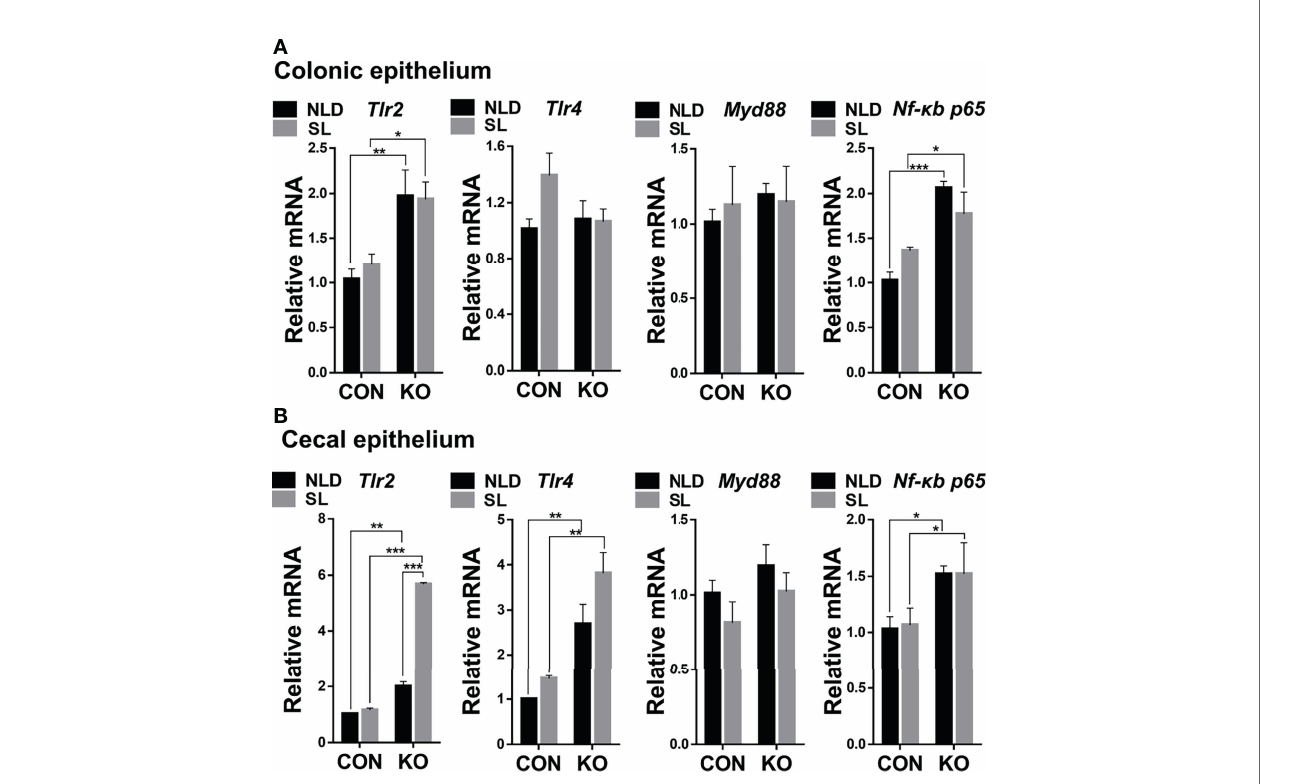
FIGURE 5 | Relative expression of colonic and cecal epithelial in fl ammatory pathways-related genes in KO and CON mice under NLD and SL. KO, Per2 gene knockout ( Period2 − / − ) mice; CON, wild-type ( Period2 +/+ ) mice; NLD, normal light – dark cycle treatment of 12 h of light and 12 of h darkness; SL, short-light treatment of 8 h light and 16 h darkness. Representative charts of the expression levels of Tlr2 gene, Tlr4 gene, Myd88 gene, and Nf- k b p65 gene of colonic epithelium (A) and cecal epithelium (B) . Expressions of in fl ammatory pathways-related were determined in Per2 knockout and wild-type mice under NLD and SL by PCR method. Statistical analyses were conducted using two-way ANOVA. * p < 0.05, signi fi cant difference; ** or *** p < 0.01 or p < 0.001, extremely signi fi cant difference. Results are presented as means ± SEM (n = 6 per